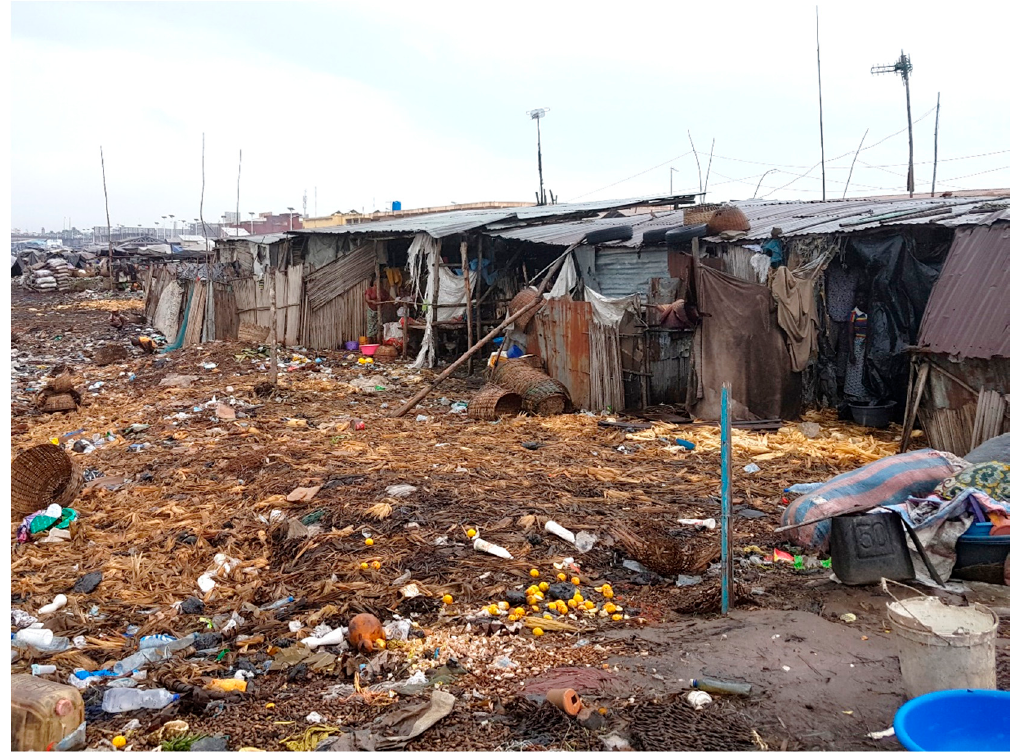
Figure 3. Typical housing units on wastelands in a cholera-infected area, largely due to the decomposition of organic wastes.